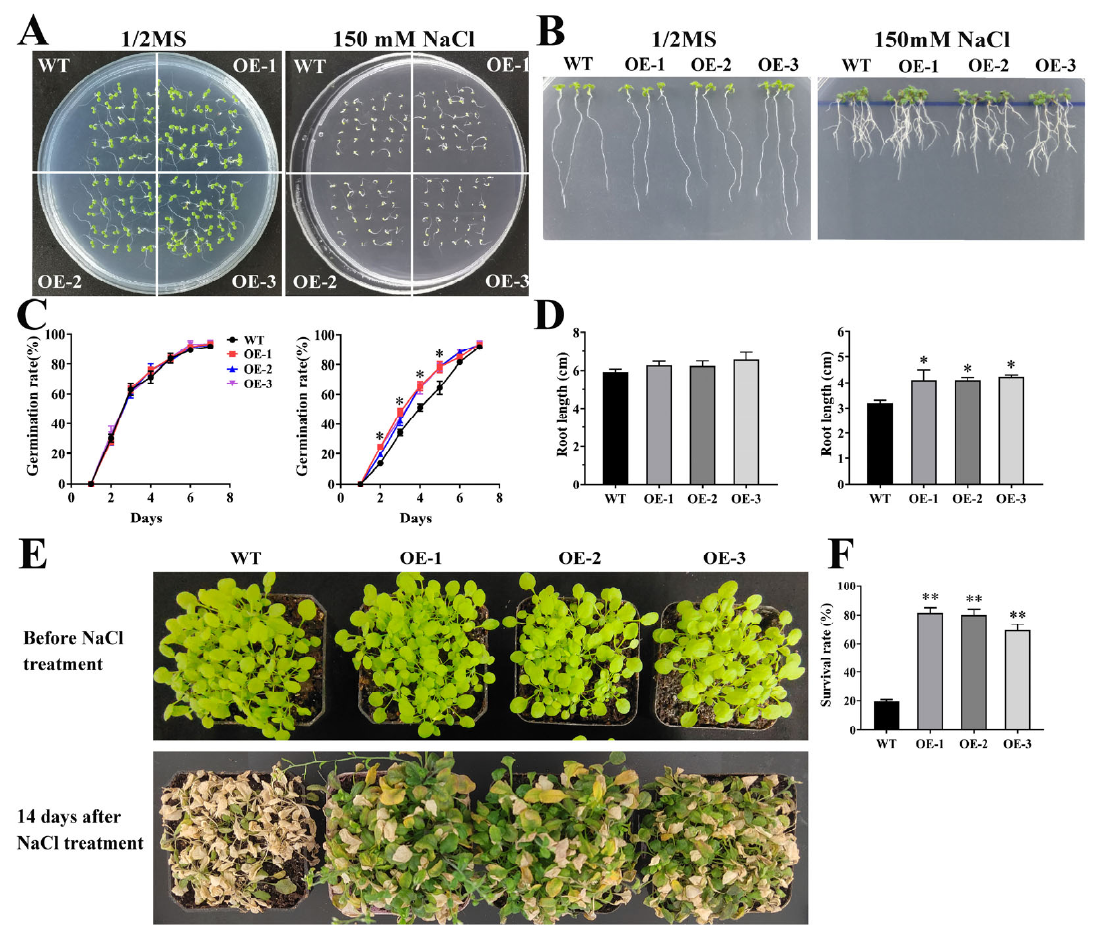
Figure 7. Overexpression of SmCIPK13 enhances salt resistance in Arabidopsis . ( A , B ). Seed germination and root length elongation phenotypes of transgenic lines and WT grown in medium of 1/2 MS and 1/2 MS containing 150 mM NaCl up to day 7. ( C , D ) Analysis of seed germination and root length elongation of transgenic lines and WT grown in 1/2 MS and containing 150 mM NaCl in 1/2 MS medium for 7 days. ( E , F ) Phenotypes of three ‐ week ‐ old transgenic Arabidopsis and WT before and after two weeks of 150 mM NaCl treatment and survival after treatment ( F ). (* p < 0.05, ** p < 0.01).